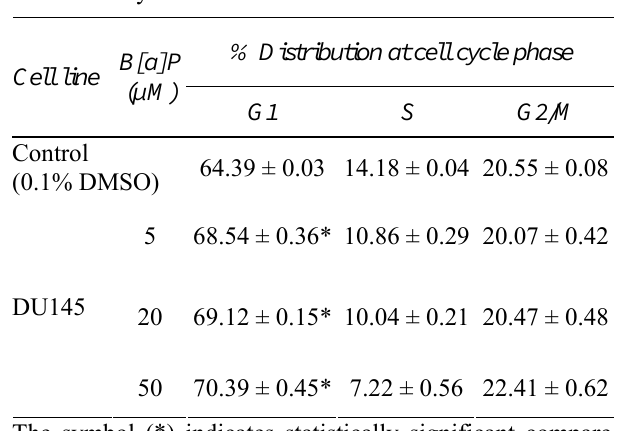
Table 2: The cell cycle distribution of DU145 after 48 h treatment with varying concentrations of BPDE. Data